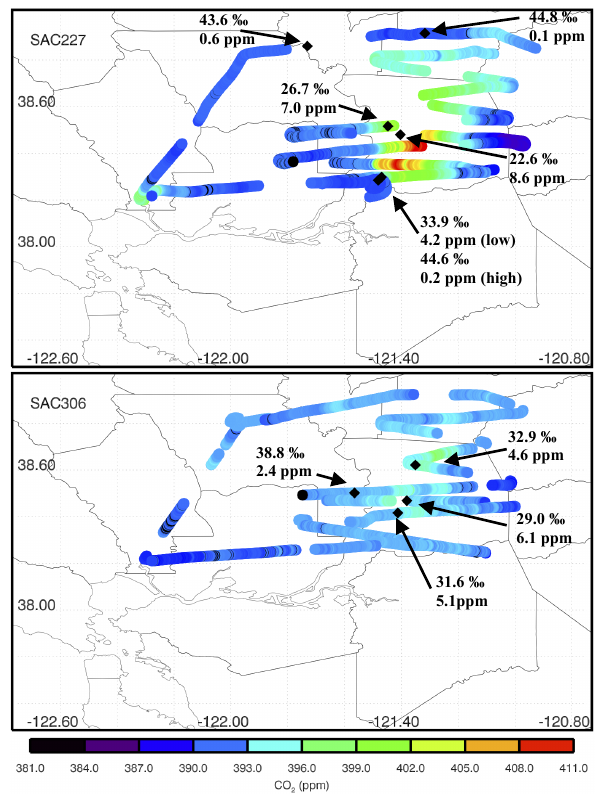
Fig. 1. Flight paths and CO 2 mole fraction (ppm) measured in situ during two flights above Sacramento on 27 February 2009 (SAC227, top) and 6 March 2009 (SAC306, bottom). Black dia- monds indicate the locations where flask samples were collected. Measured 1 14 CO 2 and calculated recently added CO 2 ff mole frac- tion are indicated for each flask. One-sigma uncertainties are 0.2ppm for in situ CO 2 , 2.5‰ for 1 14 CO 2 and ∼ 1ppm for CO 2 ff (see text). County and continent boundaries are shown for refer-